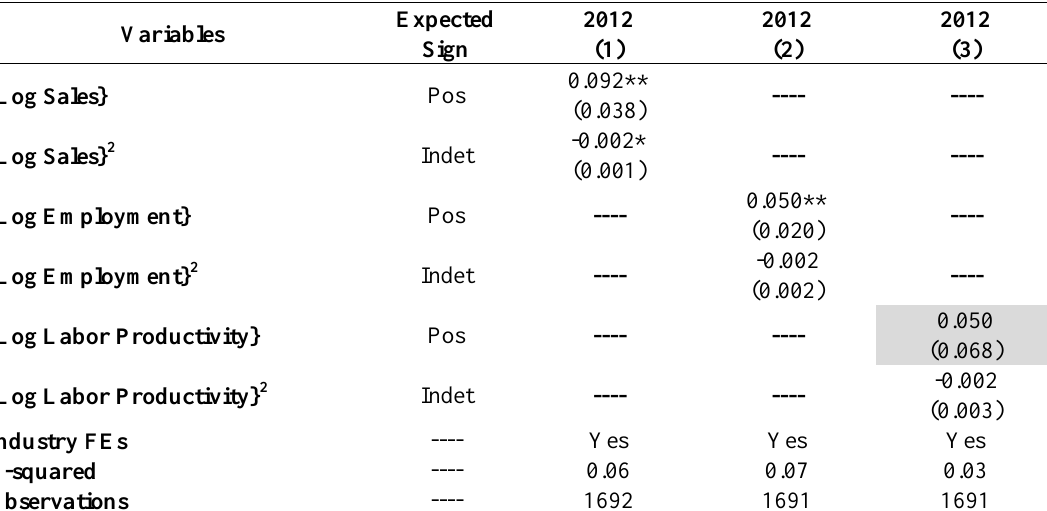
Table 4: Robustness check of AKW’s results: Prediction